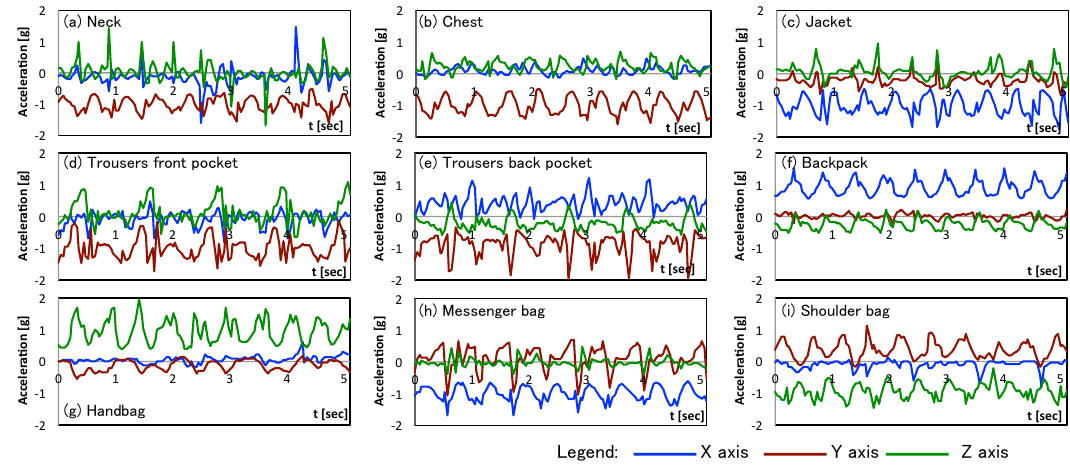
Figure 2. Raw acceleration signals from the nine target positions of a person during walking.